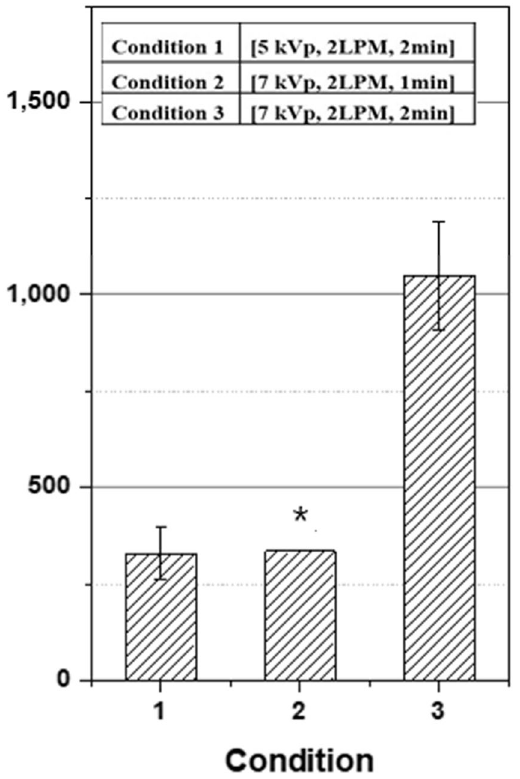
Figure 4. DMPO-OH signal intensities in an arbitrary unit from plasma treatments at three different operational setups of the plasma device in applied voltage, helium flow rate, and duration of treatment. The asterisked data for condition 2 was extrapolated from the data in Fig. 3(b). The data sets were normalized by external Mn 2 + signal intensities. Each error bar indicates one standard error of the mean obtained from three independent